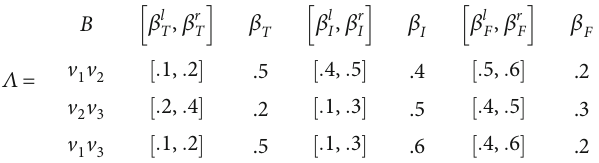
Table 5: Neutrosophic membership functions for edges.